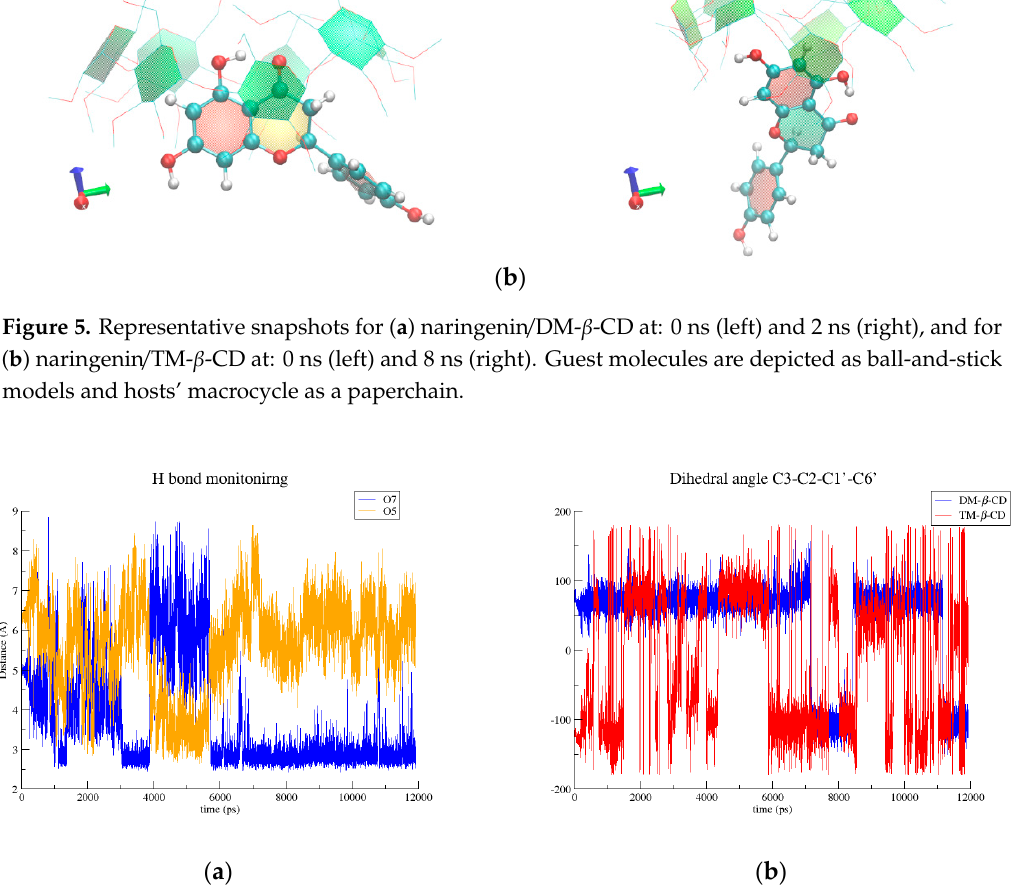
Figure 5. Representative snapshots for ( a ) naringenin / DM- β - CD at: 0 ns (left) and 2 ns (right), and for ( b ) naringenin / TM- β - CD at: 0 ns (left) and 8 ns (right). Guest molecules are depicted as ball-and-stick models and hosts’ macrocycle as a paperchain.